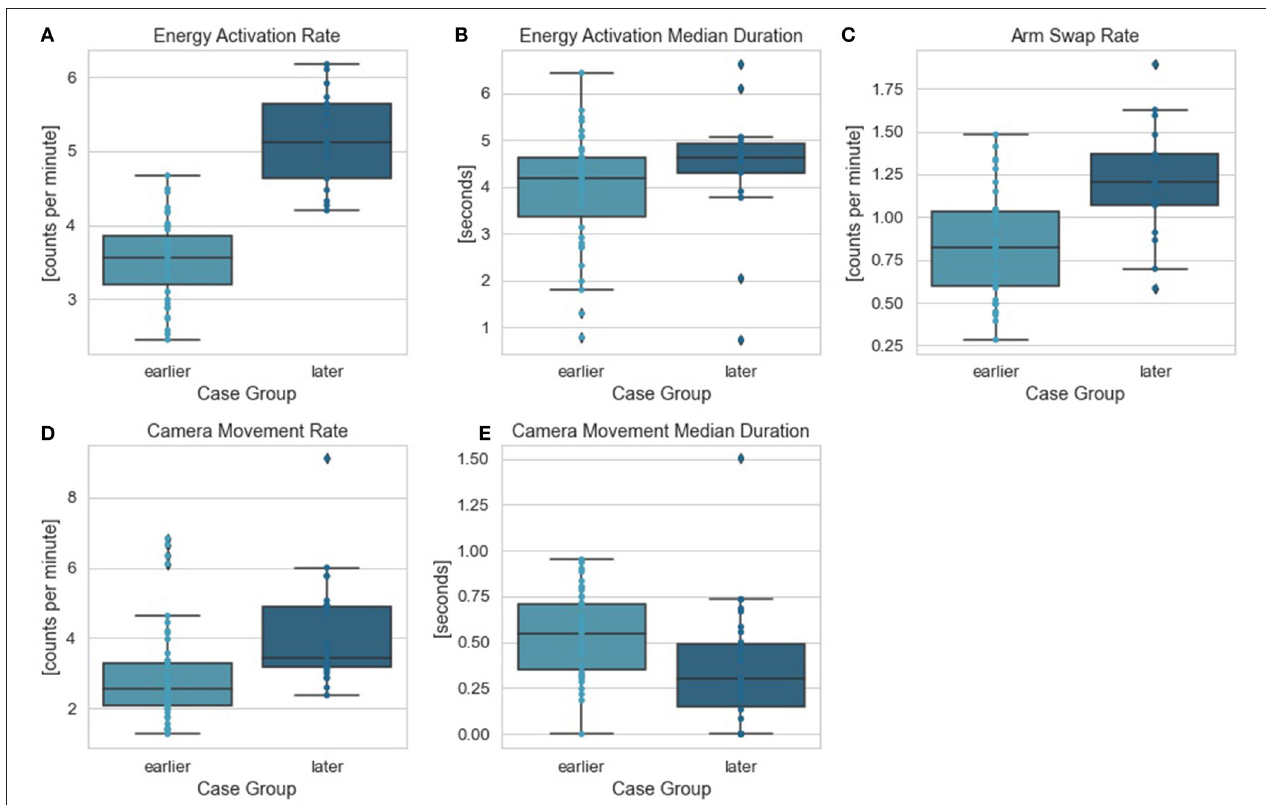
TABLE 4 | Regression models examining procedure variability by surgical task variability. Spearman correlation Multivariable linear regression Logistic regression R p value β Coefficient (95% CI) p value RFE rank RFE rank Stomach dissection 0.45 < 0.001 0.74 (0.31 to 1.17) 0.001 4 Place bougie 0.26 Stomach stapling Leak test Surgical inactivity 0.26 Bold values are corresponding to statistically significant